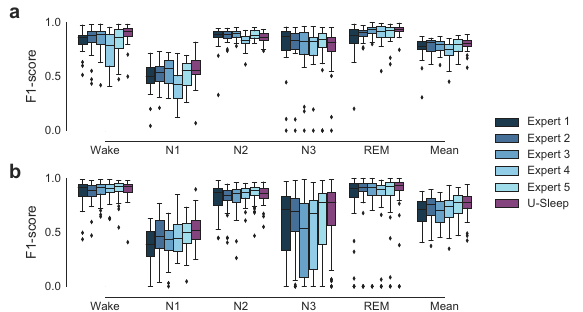
Fig. 3 Boxplots illustrating the distributions of F1 scores from 5 human experts and U-Sleep on healthy controls and OSA patients. a Shows results from dataset DOD-H on 25 healthy subjects. b Shows results from dataset DOD-O on 55 patients suffering from OSA. Sleep stages produced by U-Sleep and the fi ve individual experts were compared to consensus-scored hypnograms. Please refer to the Methods section for further details. Mean F1 scores averaged across stages are shown along with F1 scores for the fi ve individual sleep/wake stages. The performance of U-Sleep is shown in red colors (right most boxplot in each group). The performance of each human expert is shown in shades of blue (4 left most boxplots in each group). Note that some records were scored by both human experts and U-Sleep with very low F1 scores (0 in some cases) on individual classes. This especially concerns stage N3 in dataset DOD- O and most often happens for rare classes. For instance, a patient severely affected by OSA rarely enters the N3 deep sleep stage, and the resulting low number of observed N3 stages makes even a few errors result in a large deviation in the F1 score. Each boxplot shows the median (middle vertical line), fi rst and third quartiles (lower and upper box limits) and whiskers that extend to 1.5 times the IQR added or subtracted the third and fi rst quartiles, respectively. Data outside of this range is marked as outliers indicated by diamond shaped